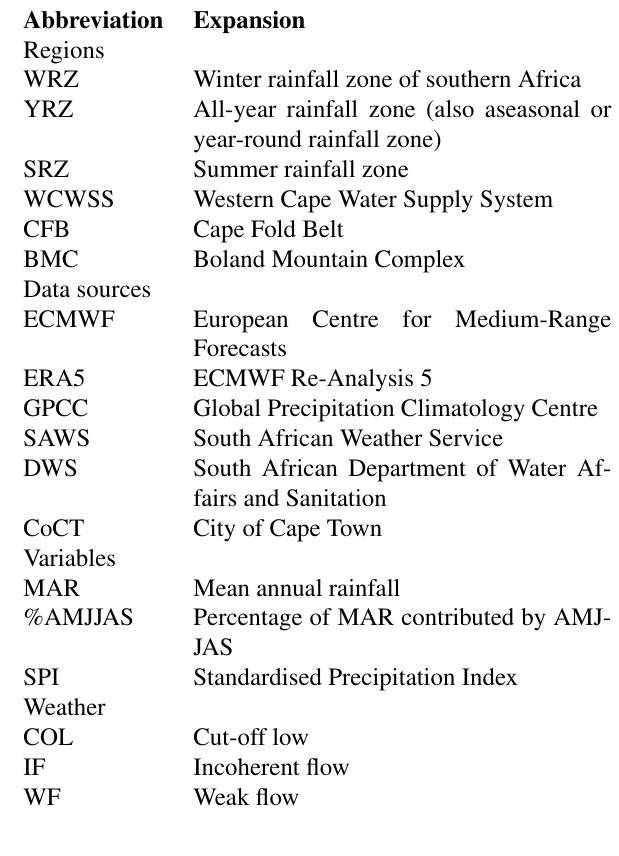
A3 List of abbreviations used in the text and/or